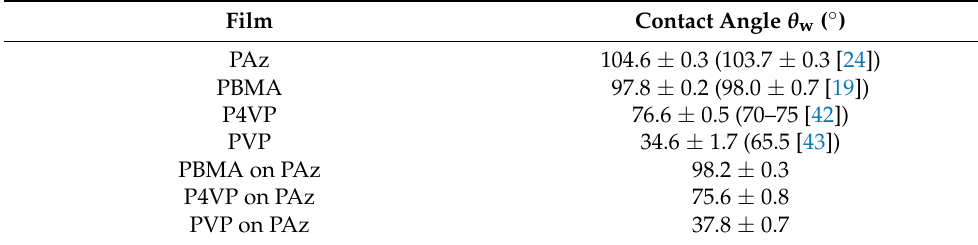
Table 2. Static contact angles of water droplets at room temperature.